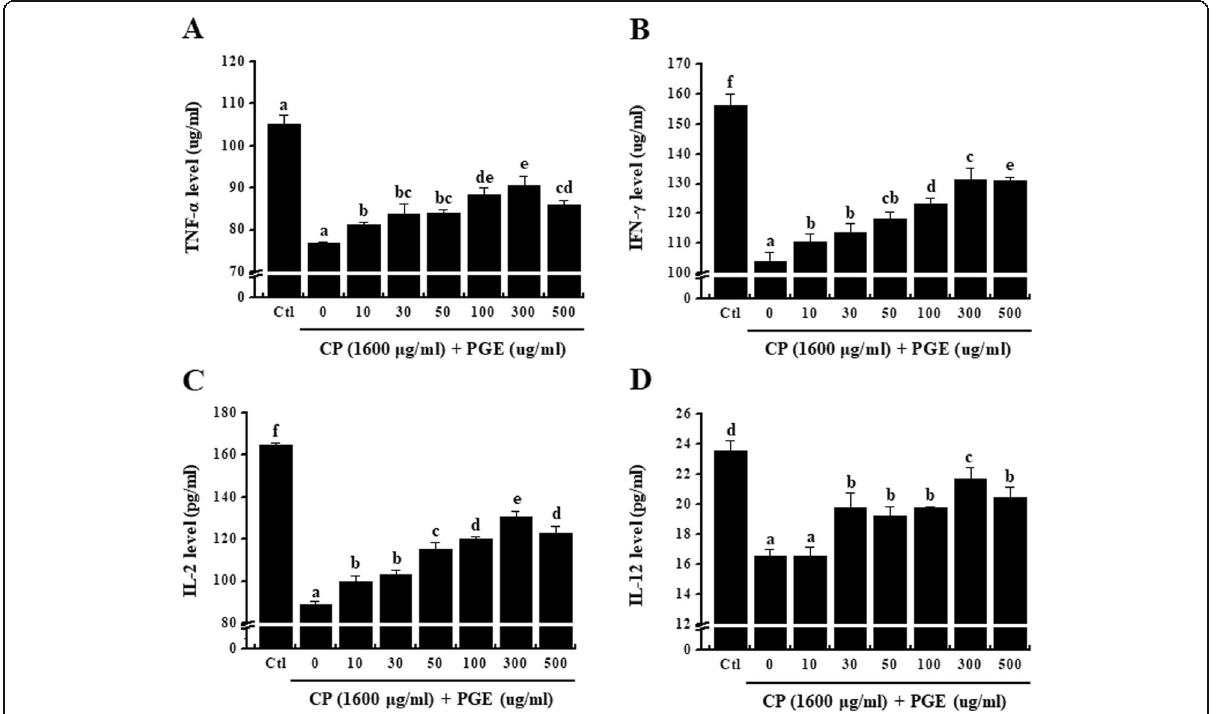
Fig. 3 Effect of PGE on cytokine levels in CP-treated splenocytes. Cells were seeded into 96-well plates, followed by treatment with PGE (0, 10, 30, 50, 100, 300, and 500 μ g/mL) and/or CP (1600 μ g/mL) and incubated for 24 h under 5% CO 2 . a – d Level of cytokines (TNF- α , IFN- γ , IL-2, and IL-12) secreted into the culture medium was analyzed using ELISA kits. Bars labeled with different superscripts have significantly different values ( P < 0.05). Data are presented as the means ± standard errors ( n =